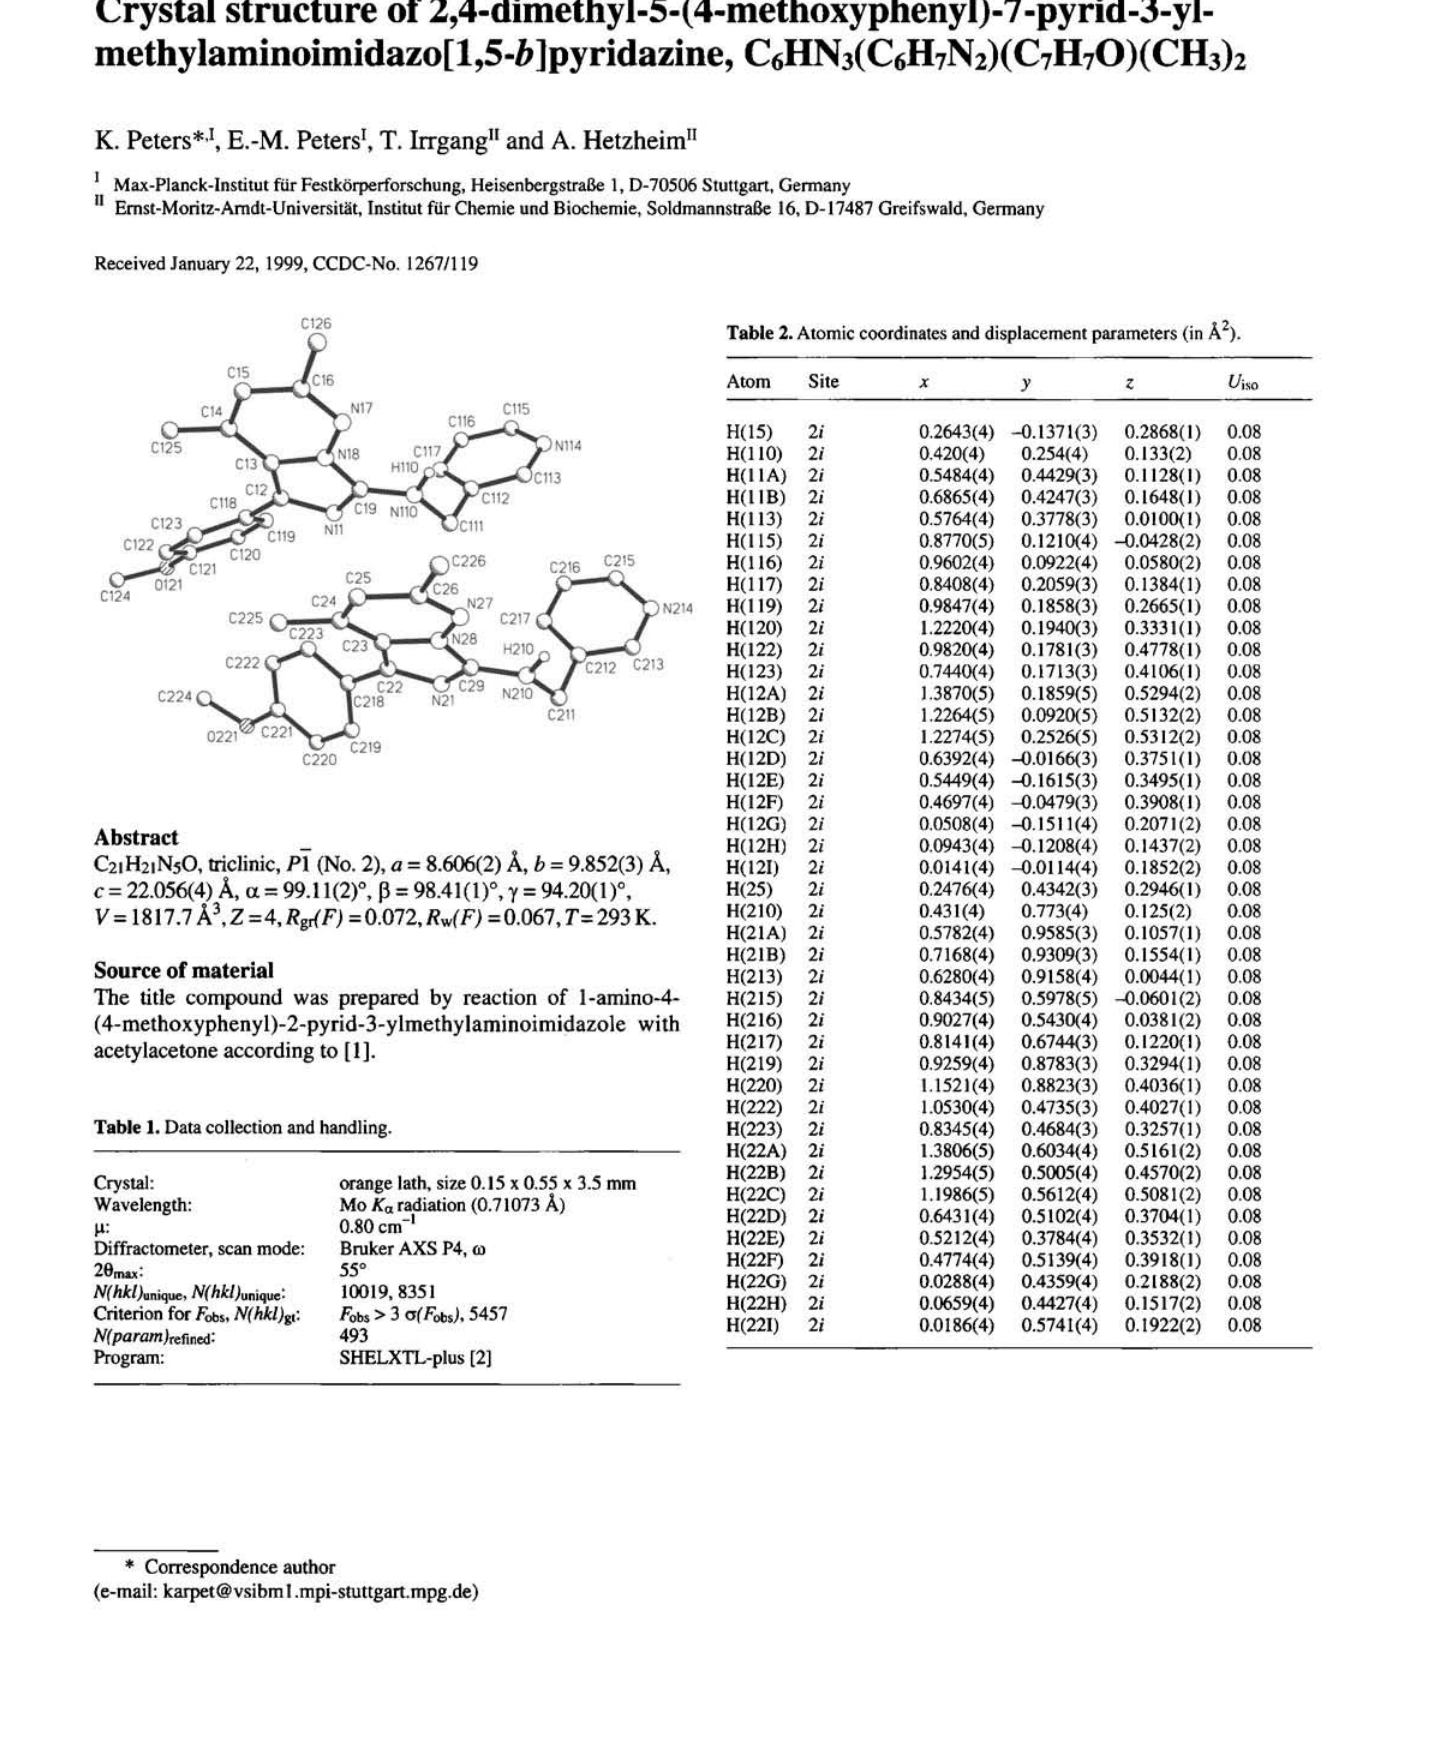
Table 1. Data collection and